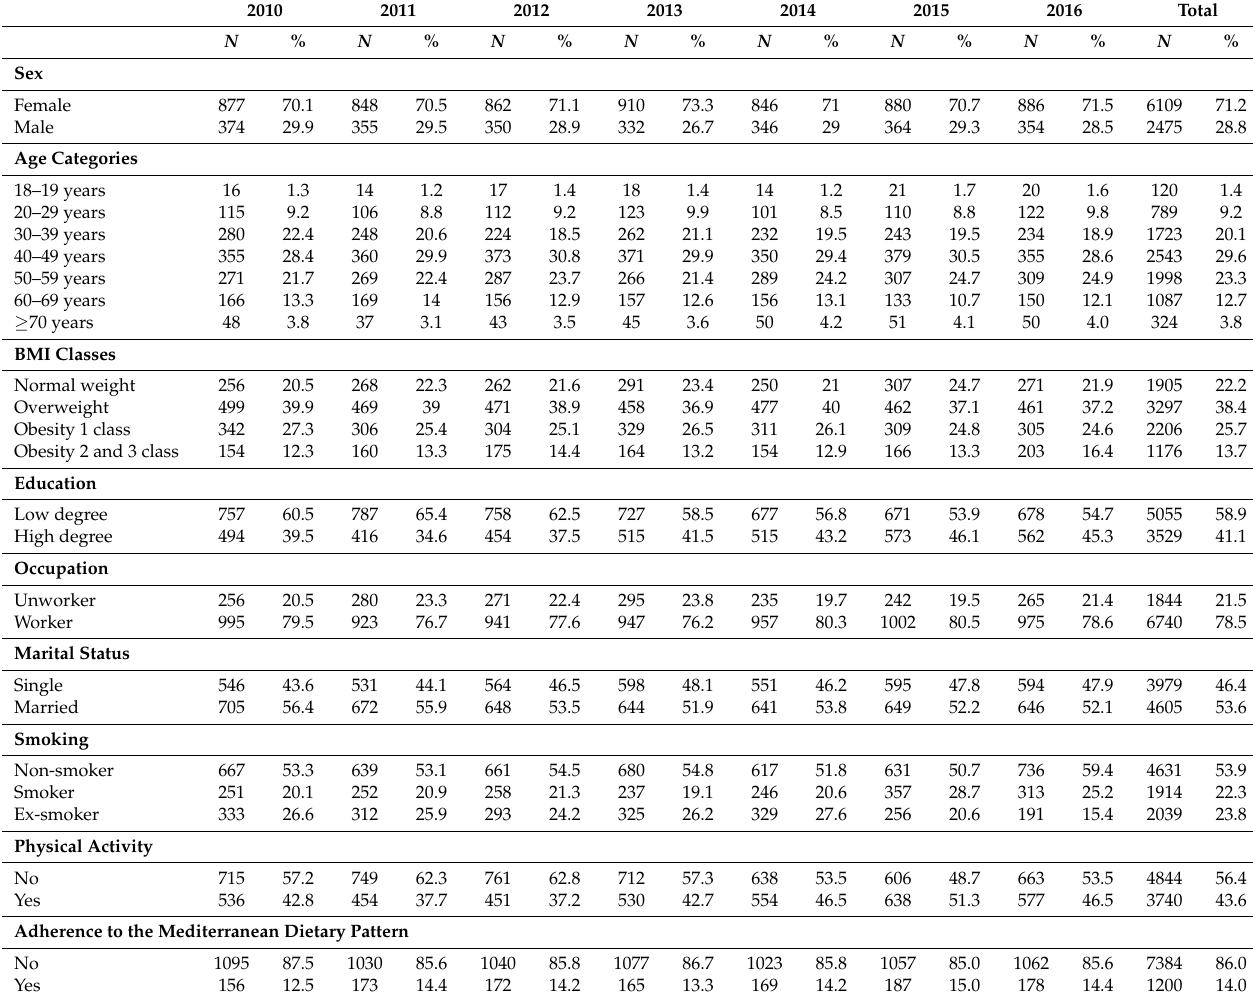
Table 2. Socio-anagraphic, nutritional status and lifestyle characteristics of the sample according to the year of